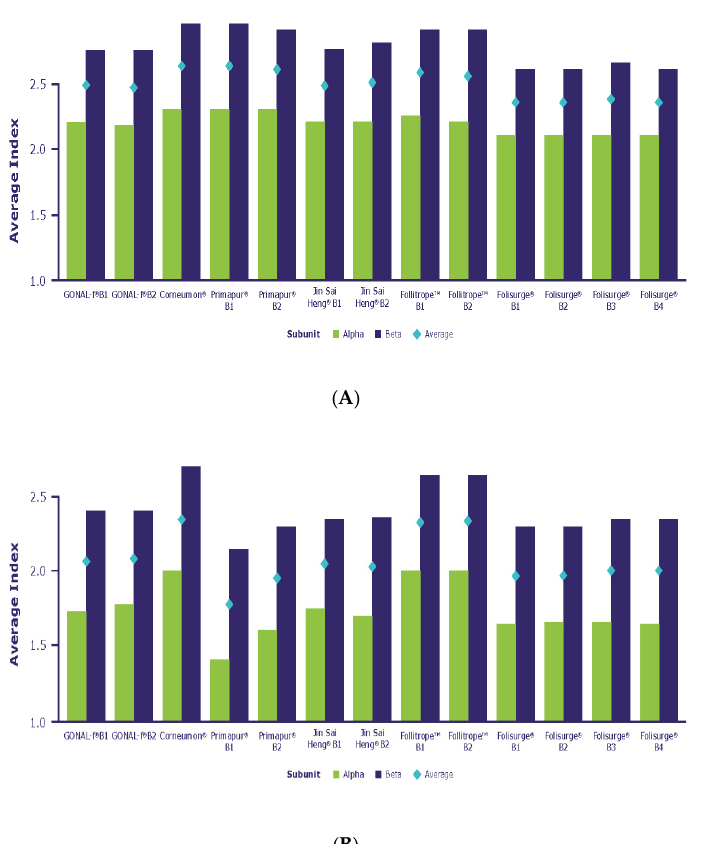
Figure 3. ( A ) Antennarity (A-Index) and ( B ) sialylation (S-Index) of selected biosimilar preparations. The extent of glycan branching and the degree of sialylation are key features of glycan structure. The average number of antennae and sialic acid moieties per glycan is reflected by the A-Index and the S-Index, respectively. Such indexes are calculated for each N - glycosylation site and as a mean over the entire molecule. Table 2. Degree of NGNA and O -acetylation for GONAL-f ® , Corneumon ® , Primapur ® and Jin Sai Heng ® .